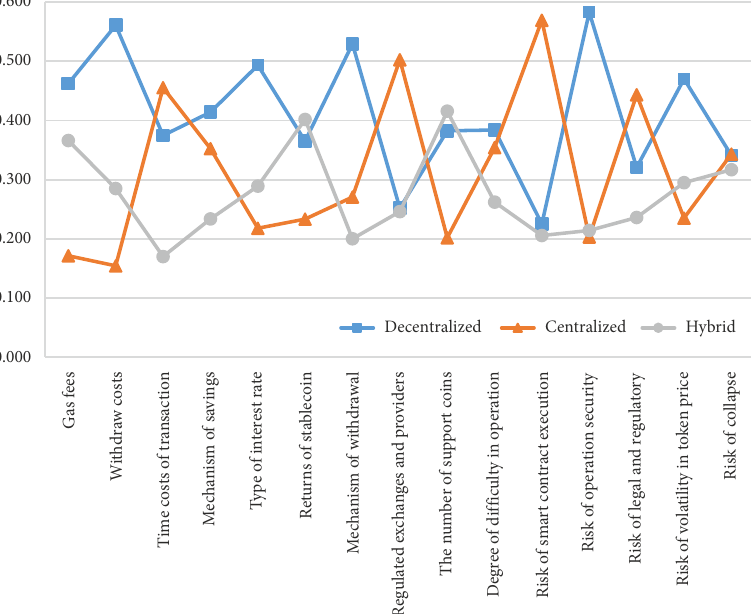
Figure 3. The factors performance of three